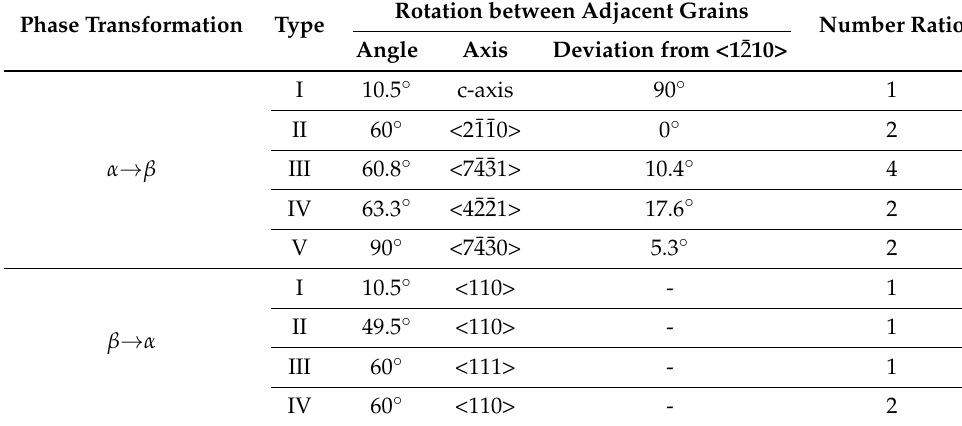
Table 3. Special boundaries for